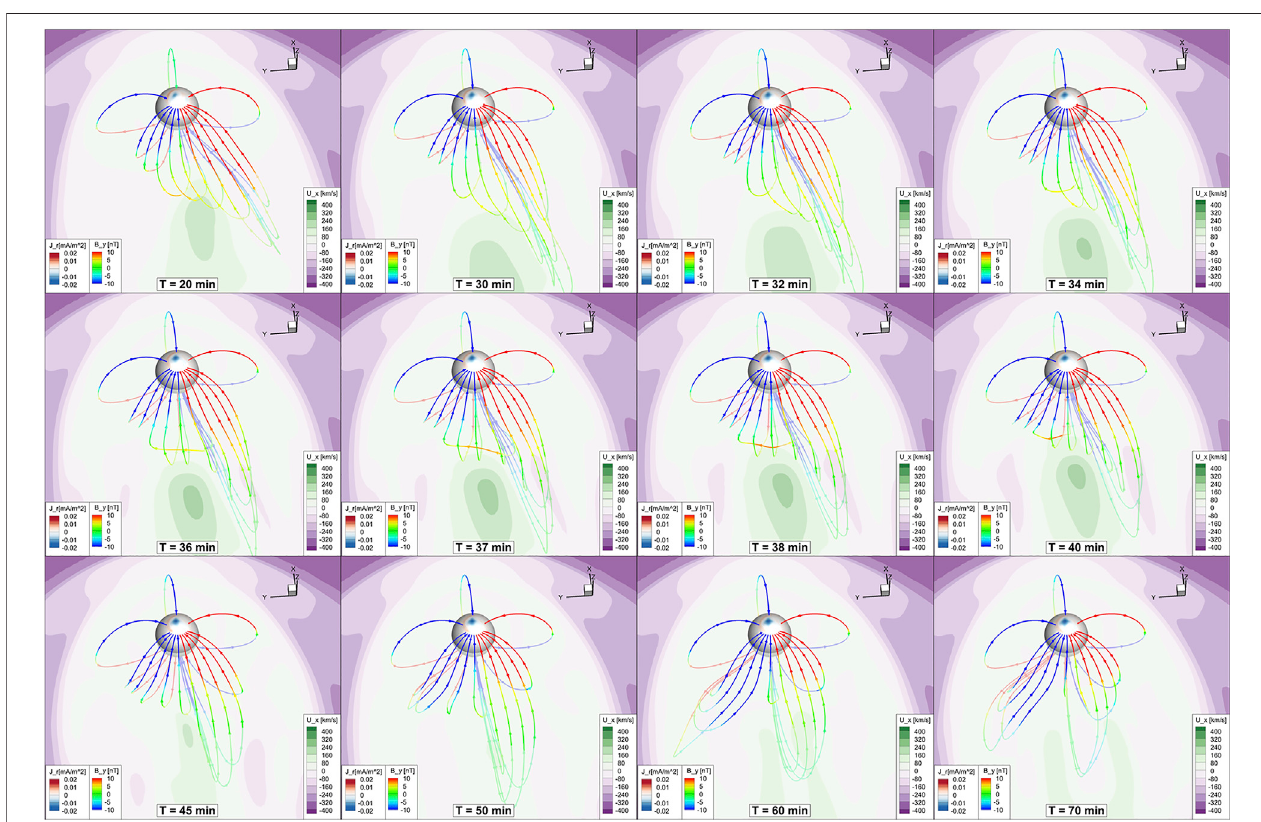
FIGURE 4 | Nightside magnetospheric con fi guration. Streamlines indicate magnetic fi eld lines with the color representing B y component. The background color indicates U x . The color on the sphere near the Earth indicates FACs